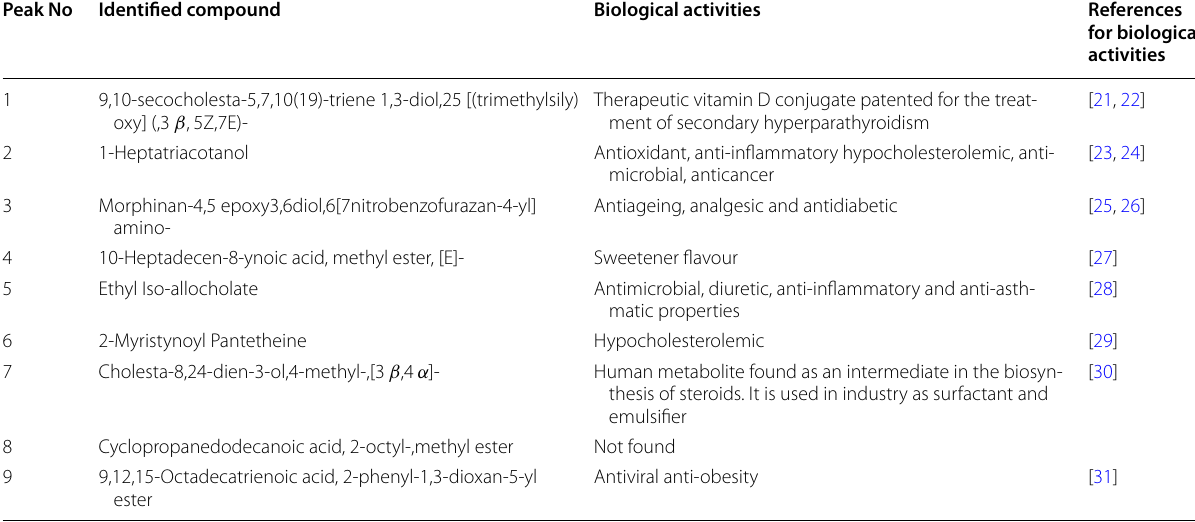
Table 3 Biological activities the compounds identified from Eucalyptus globulus leaf extract using